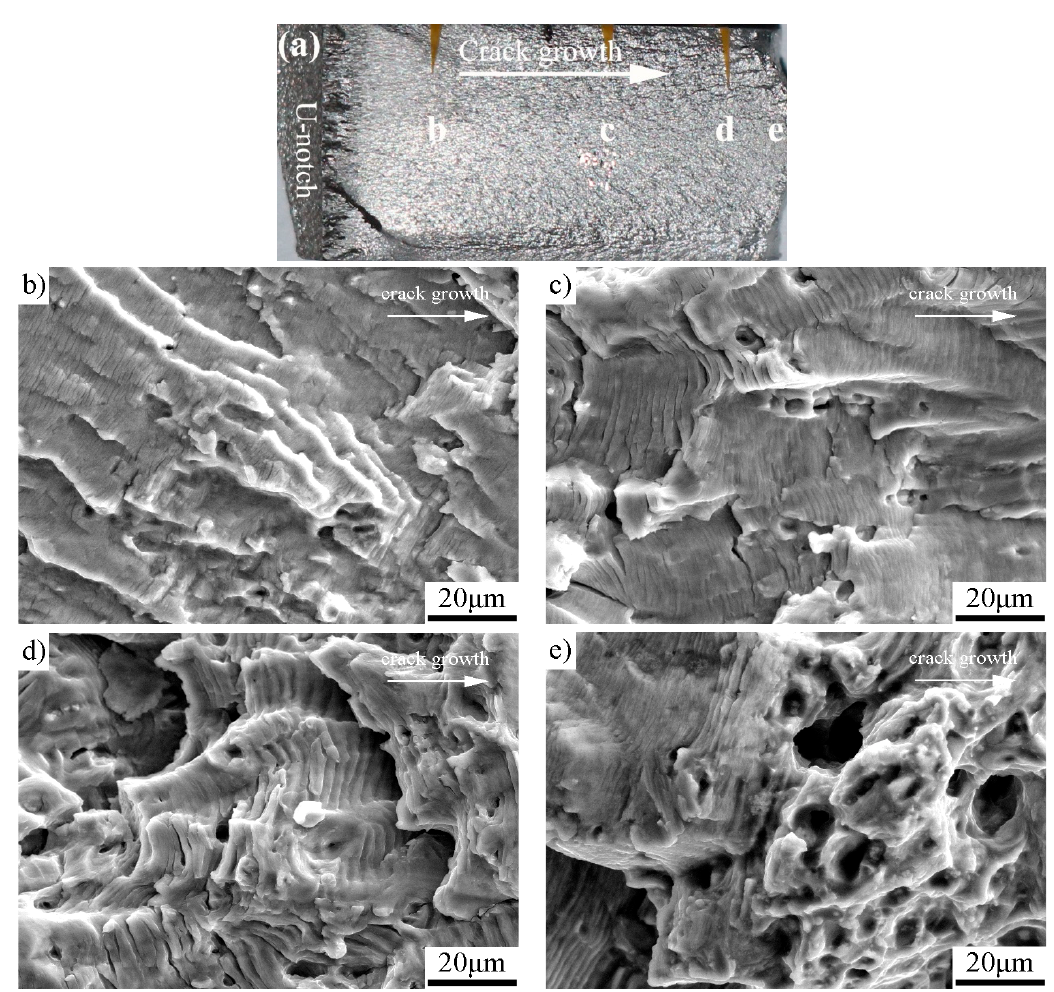
Figure 8. The pre-stressed specimen with pre-stress of 183 MPa: ( a ) macrograph showing the detailed SEM locations; ( b ) Δ K app ≈ 20 MPa √m ; ( c ) Δ K app ≈ 30 MPa √m (striation spacing ≈ 2.6 μ m); ( d ) Δ K app ≈ 40 MPa √m (striation spacing ≈ 4.9 μ m); and ( e ) unstable propagation zone.